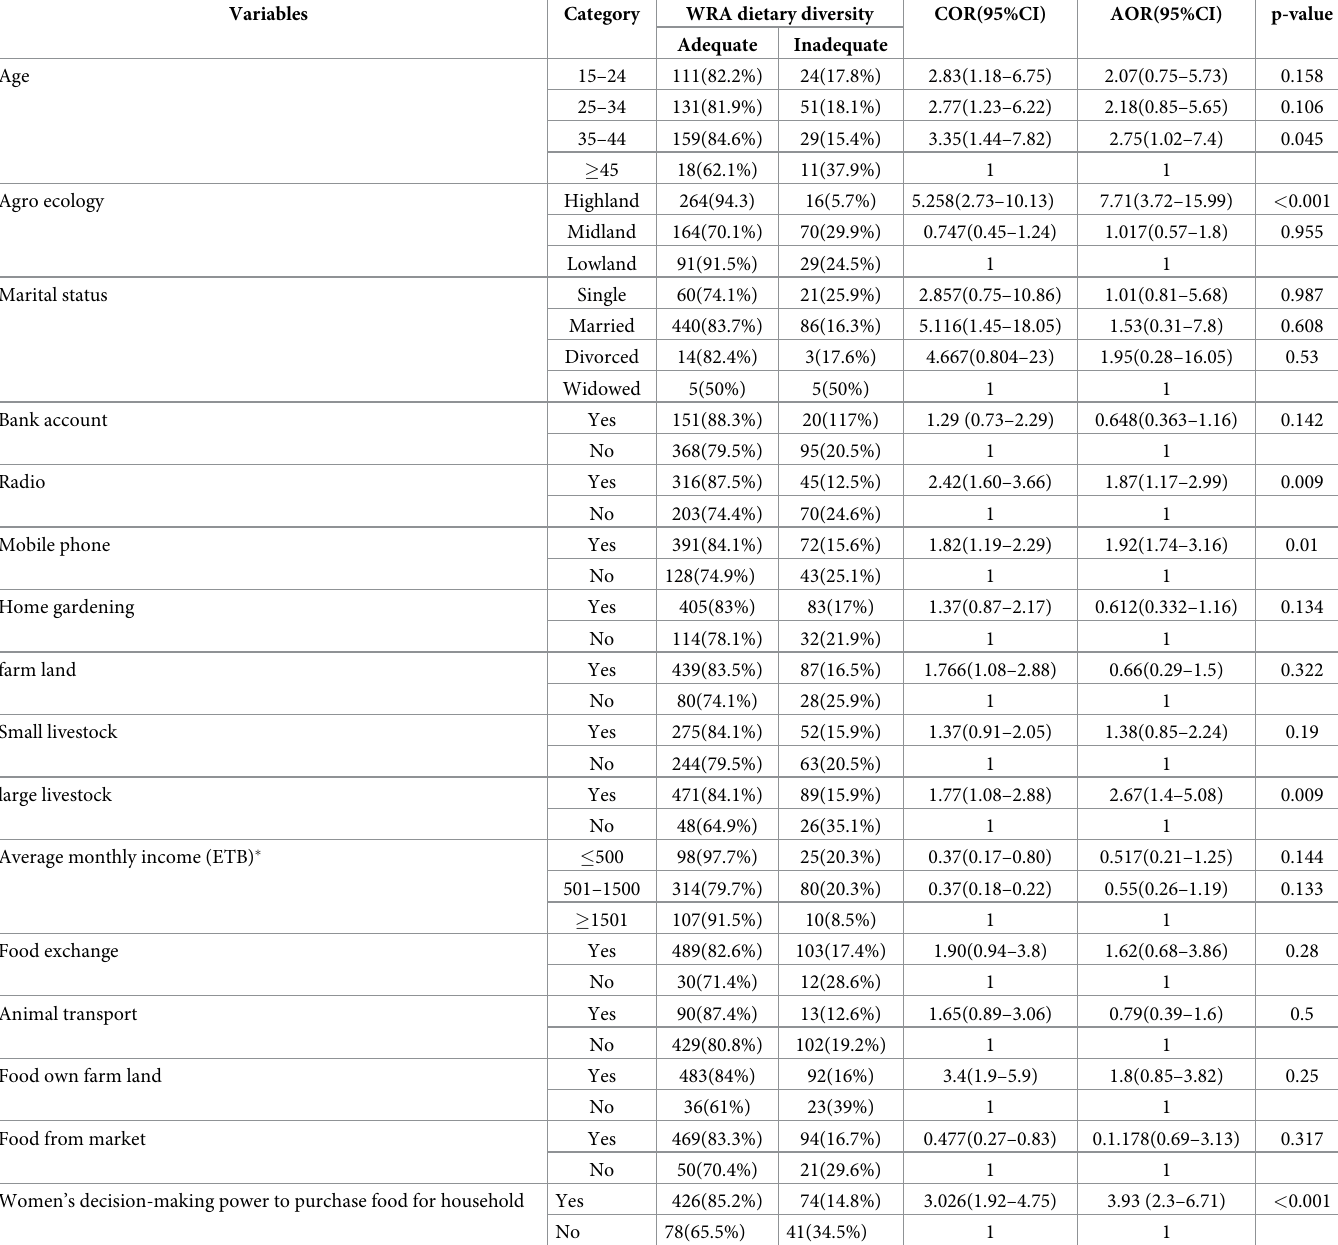
Table 3. Binary and multivariable logistic regression model showing socio demographic, socio economic and personal food environment factors associated with dietary diversity among reproductive age women in Jeldu district West Shoa zone, Oromia, Ethiopia, March 25 –April 15,